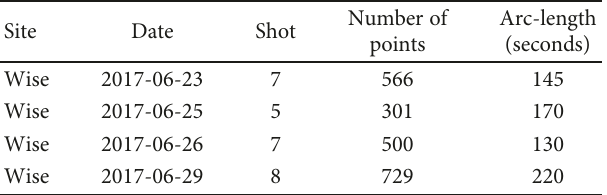
Figure 7: Maximum in-track direction di ff erence in kilometers between the estimated orbit and the reference orbit during seven days after the end of orbit estimation with 5 optical observation test cases for seven days. Table 4: Observation summary of KOMPSAT-1 from